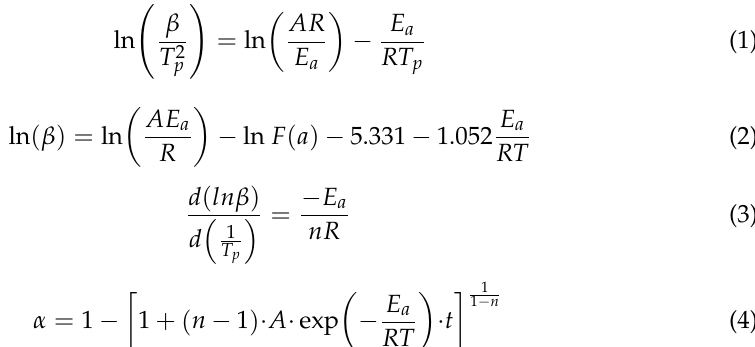
where β is the heating rate, K/min; T p is the exothermic peak temperature, K; E a is the apparent activation energy, J/mol; R is the perfect gas constant of 8.314 J/(mol · K); and F ( a ) is a constant function.